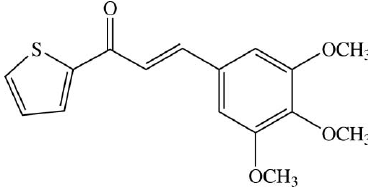
56940 measured reflections 7416 independent reflections